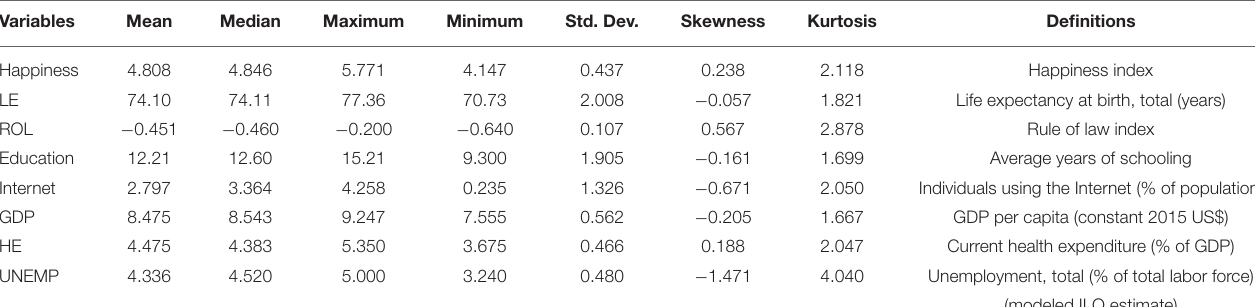
TABLE 1 | Definitions and data